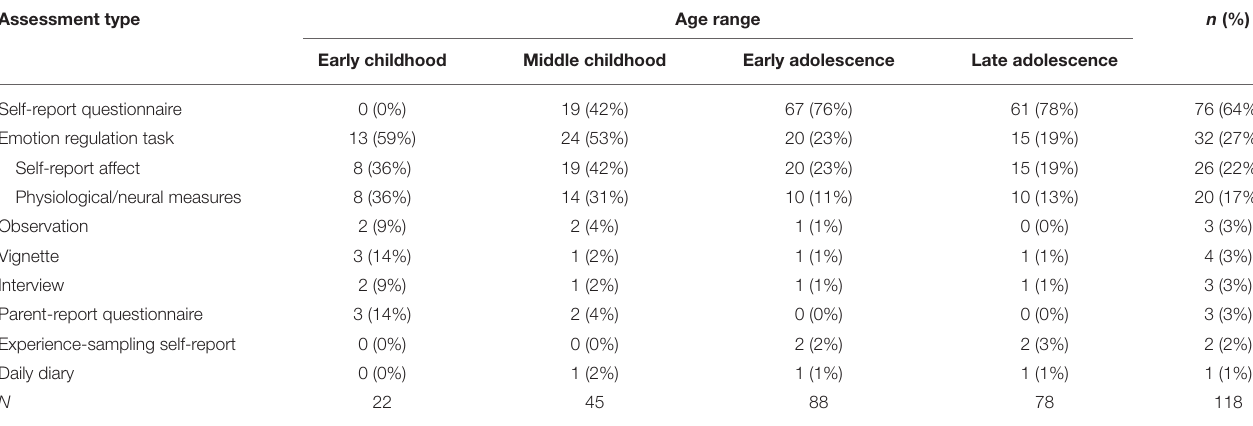
TABLE 3 | Types of assessments used to measure reappraisal, by age ranges included in the study sample. Assessment